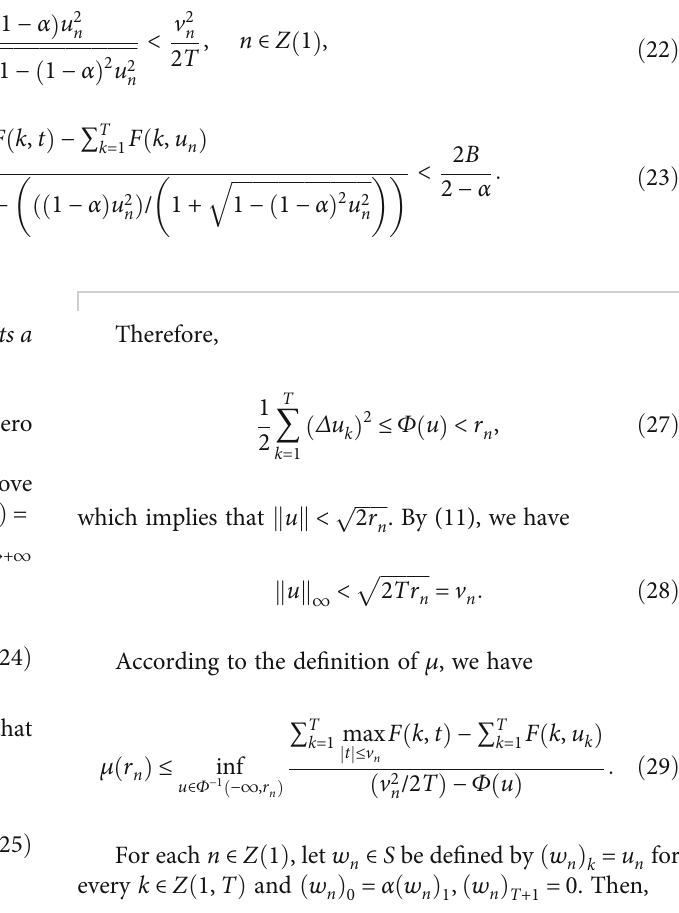
p ffiffiffiffiffiffiffiffiffiffiffiffiffiffiffiffiffiffiffiffiffiffiffiffiffiffiffi ffiffiffiffiffiffiffiffiffiffiffiffi 1 − u 2 n